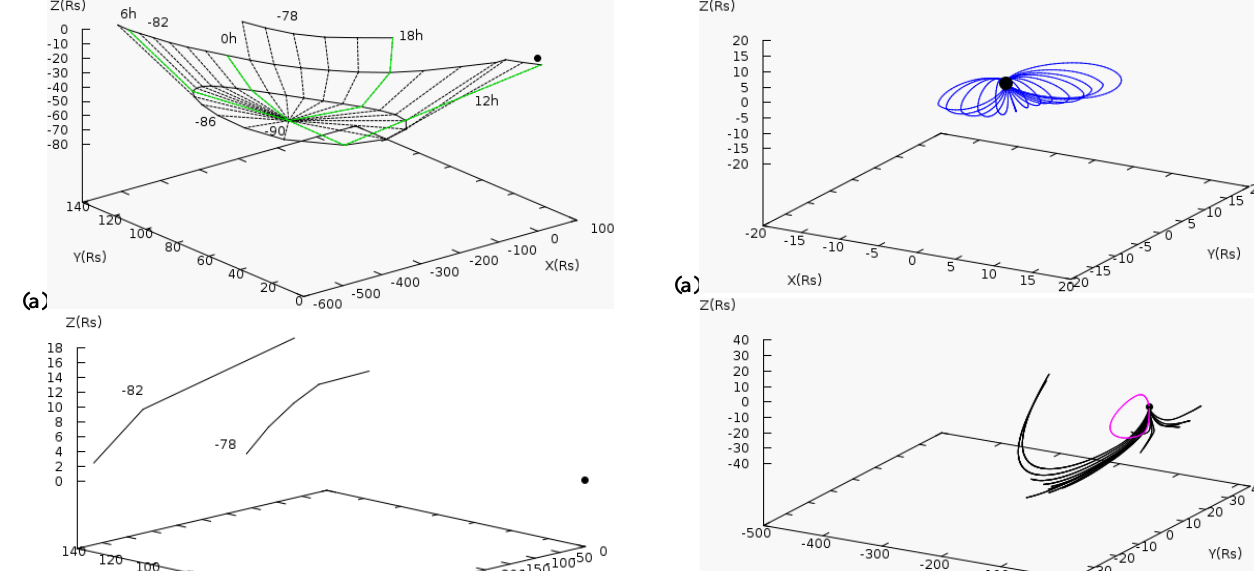
The equatorial intersections of these boundary field lines are depicted in Fig. 10 in a similar format to Fig. 6, where panel (a) uses the same spatial scales as Fig. 6 showing the near-planet region, while panel (b) shows a larger region ex- tending down the magnetospheric tail. The closed field re- gion is contained between the red and green lines, the for- mer being projected from the southern ionosphere and the latter from the northern, which now extends to much greater distances down the tail than for case C. These lines are con- nected to each other at intersections of the magnetic separator line with the equatorial plane. (For a discussion of the “open” field geometries occurring for northward- and southward- directed IMF in these cases, corresponding to southward- and northward-directed IMF at Earth due to the differing plane- tary dipole directions, the reader is referred to the works of Alexeev and Belenkaya (1983) and Blomberg et al. (2005), and references therein.) The blue squares again show the equatorial intersections of the equatorward boundary of the dayside oval, which as for case C is somewhat variably lo- cated between the outer edge and centre of the ring current region, ∼ 8.5–12.5 R S . In this case, however, it is located near the outer edge of the ring current in the dawn and post- noon sector, and near the centre in the pre-noon sector. With regard to the poleward boundary, only one of the model field lines intersects the equator, shown by the purple square close to the magnetopause in the post-dawn